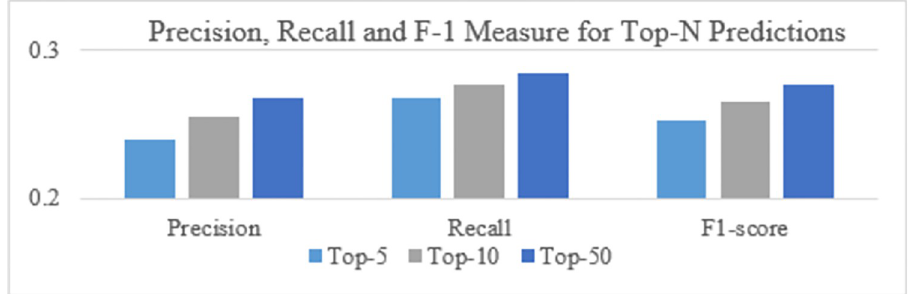
Fig 13. Precision, recall and F-1 measures for DTLME